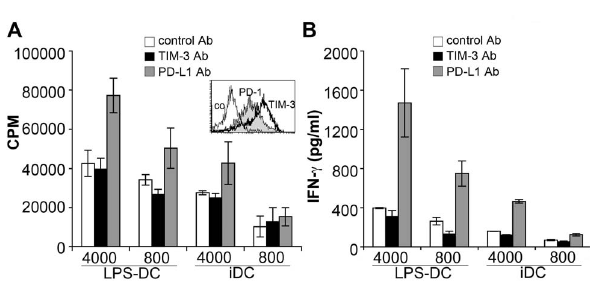
Figure 4. PD-L blockade but not TIM-3 antibodies increase allogeneic responses of human Th1 cells. Human MNC were stimulated under Th1 polarizing conditions. The expression of PD-1 (grey histogram) and TIM-3 (bold line) following Th1 polarization is shown (inset). Subsequently, polarized cells were co-cultured with immature and mature allogeneic DC (iDC and LPS-DC, respectively; numbers of DC/well are indicated) in presence of antibodies to TIM-3 or to PD-L1. Proliferation (A) and IFN- c production (B) was measured following 6 days of cultures. The results of triplicate measurements of one experiment representative for four experiments are shown.